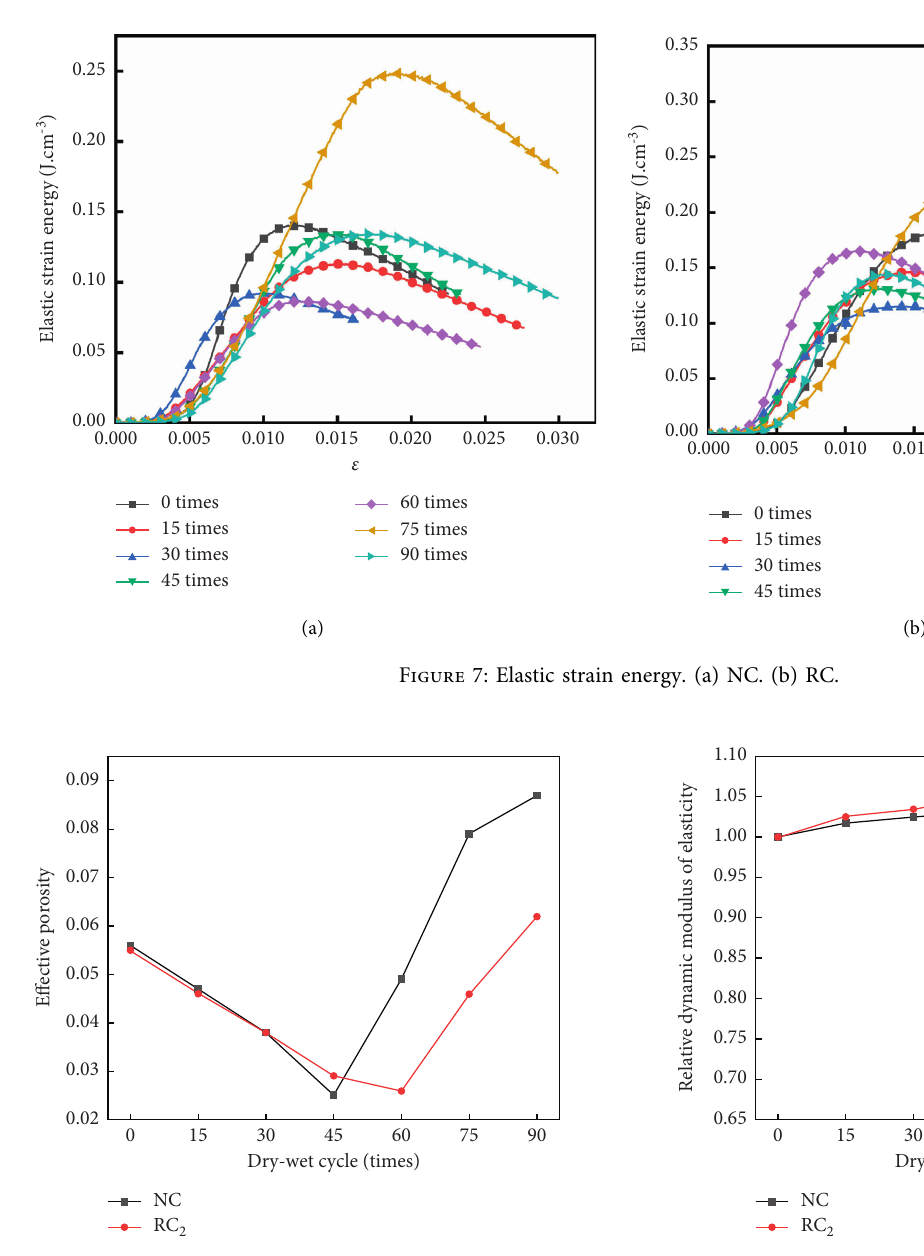
Figure 8: Effective porosity. Figure 9: Relative dynamic modulus of